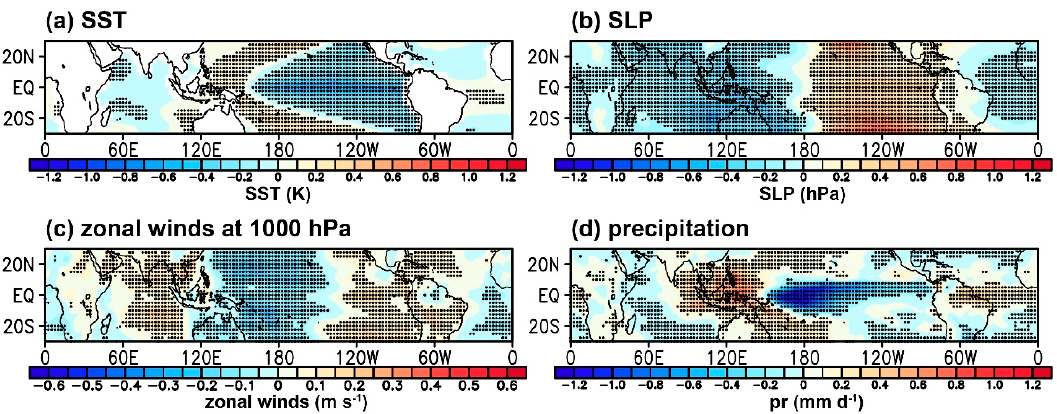
Figure 11. Spatial pattern of the regressed ( a ) SST (K), ( b ) SLP (hPa), ( c ) zonal winds of the zonal circulation at 1000 hPa (m s − 1 ), and ( d ) precipitation (mm d − 1 ) against the normalized PWC intensity index based on the air temperature for the period 1961–2012. The regression coefficients statistically significant at the 5% confidence level are dotted in black.